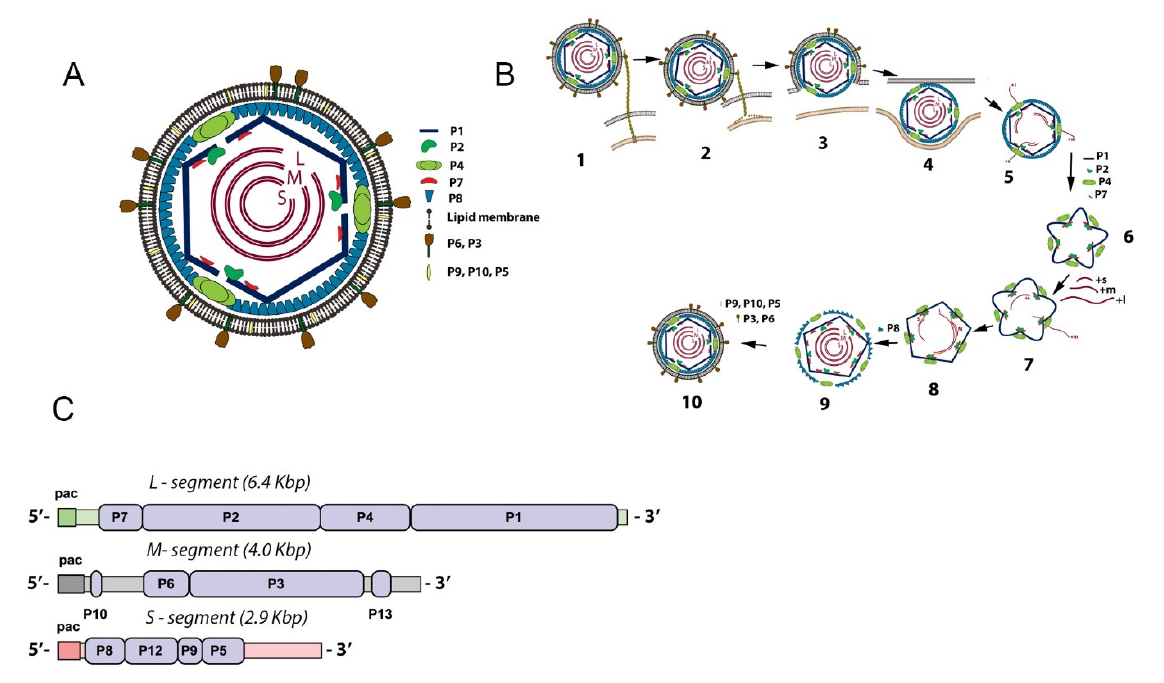
Figure 1. Schematic organization ( A ), replication cycle ( B ), and genome organization ( C ) of the ϕ 6 virion particle. ( A ) The inner layer, procapsid (PC), includes the shell composed of 120 copies of the P1 protein or 60 nonsymmetric dimers of P1A/P1B. Inside the shell are proteins P2 and P7 localized at the fivefold axis of symmetry portal and three double ‐ stranded RNA segments (dsRNA) which have low ‐ symmetry quasi ‐ concentric shell organization. The P4 proteins form a hexameric ring around the fivefold axis. The nucleocapsid (NC) includes the PC and a matrix composed of protein P8. The completed virion has an envelope derived from the cellular bilayer lipid membrane and incorporates proteins P3, P6, P9, and P5 randomly distributed. ( B ) The replication cycle initiates when P3 protein attaches to the host pili followed by pili retraction (1–2). The viral envelope fuses to the host outer membrane (3). The NC enters the periplasmic space and the cytoplasm (4). The P8 matrix disassembles, and transcription begins (5). The PC self ‐ assembles from P1, P2, P4, and P7 proteins (6) and packages the three genome transcripts accompanied by PC expansion (7). ssRNA is replicated to dsRNA (8), and the P8 matrix loosely assembles around the filled PC (9). The cell ‐ derived bilipid membrane is placed around the NC particle mediated by the nonstructural protein P12 (10). This step is followed by cell lysis and virion release. ( C ) The three ds ‐ RNA genome segments and genes encoding the viral proteins (shown in light ‐ blue color). The packaging pac signal for each strand located at the 5 ′ end of ds ‐ RNA is visualized as colored rectangles. The replication signal is located at the 3 ′ end.